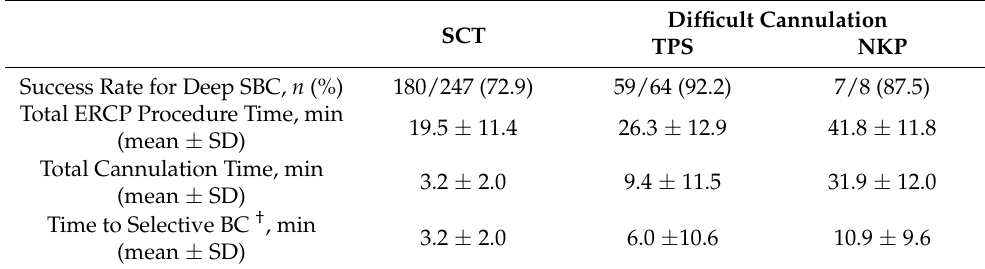
Table 3. Technical outcomes of the patients with difficult biliary cannulation.